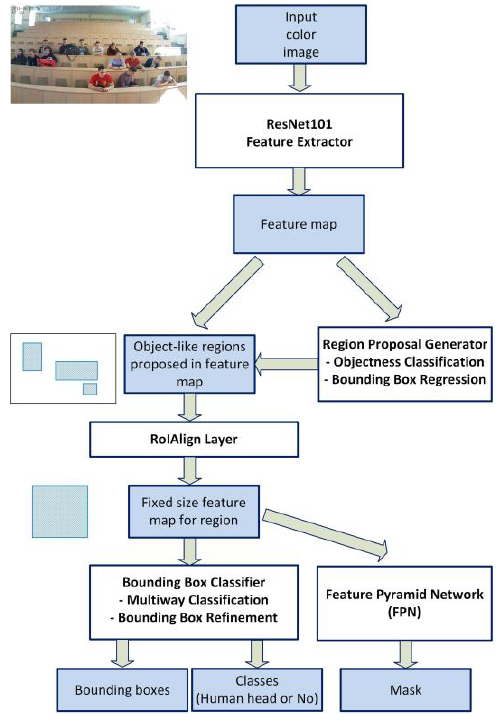
Figure 5. Human head detector based on Mask R-CNN